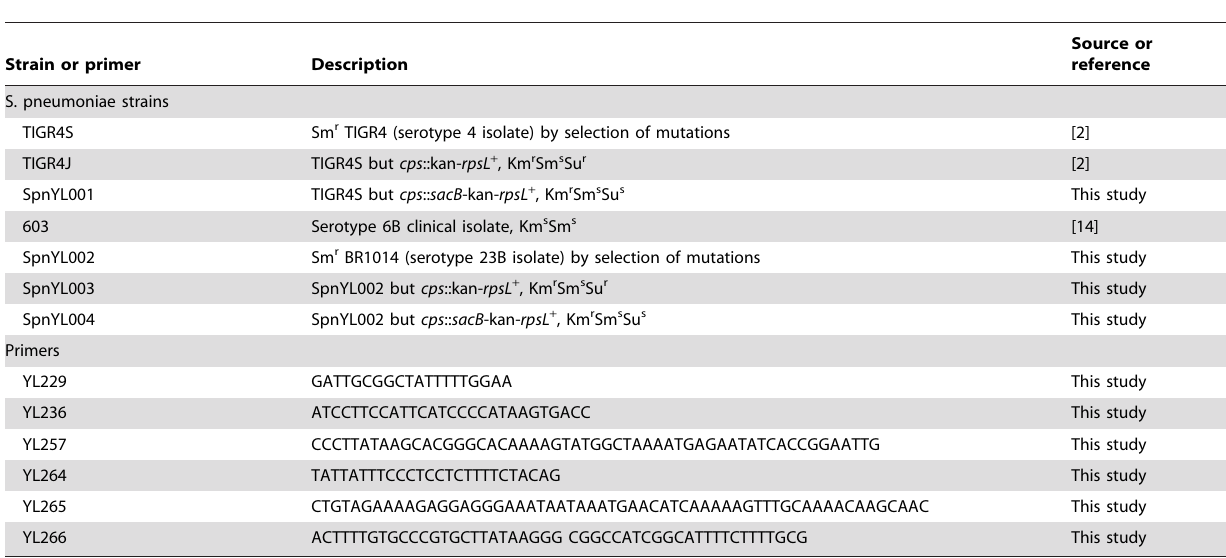
Table 1. Bacterial strains and primers used in this